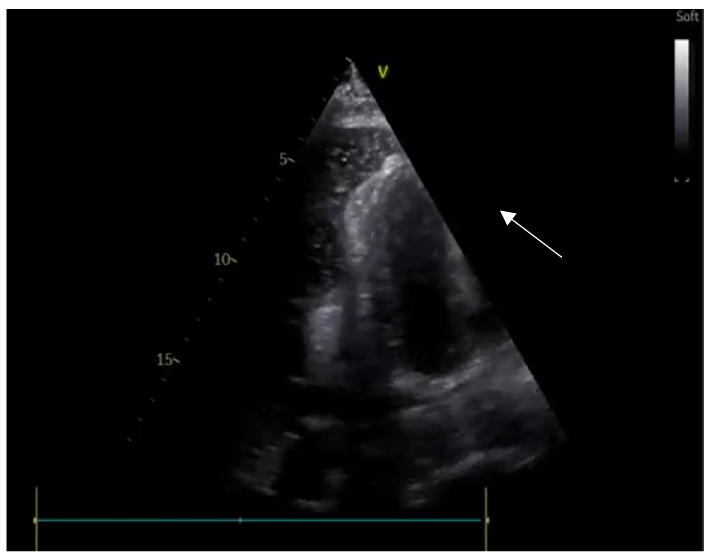
Figure 8. Bubble test during pericardiocentesis: appearance of bubbles in the pericardium (arrow) indicates that the needle is correctly positioned in the pericardial space.